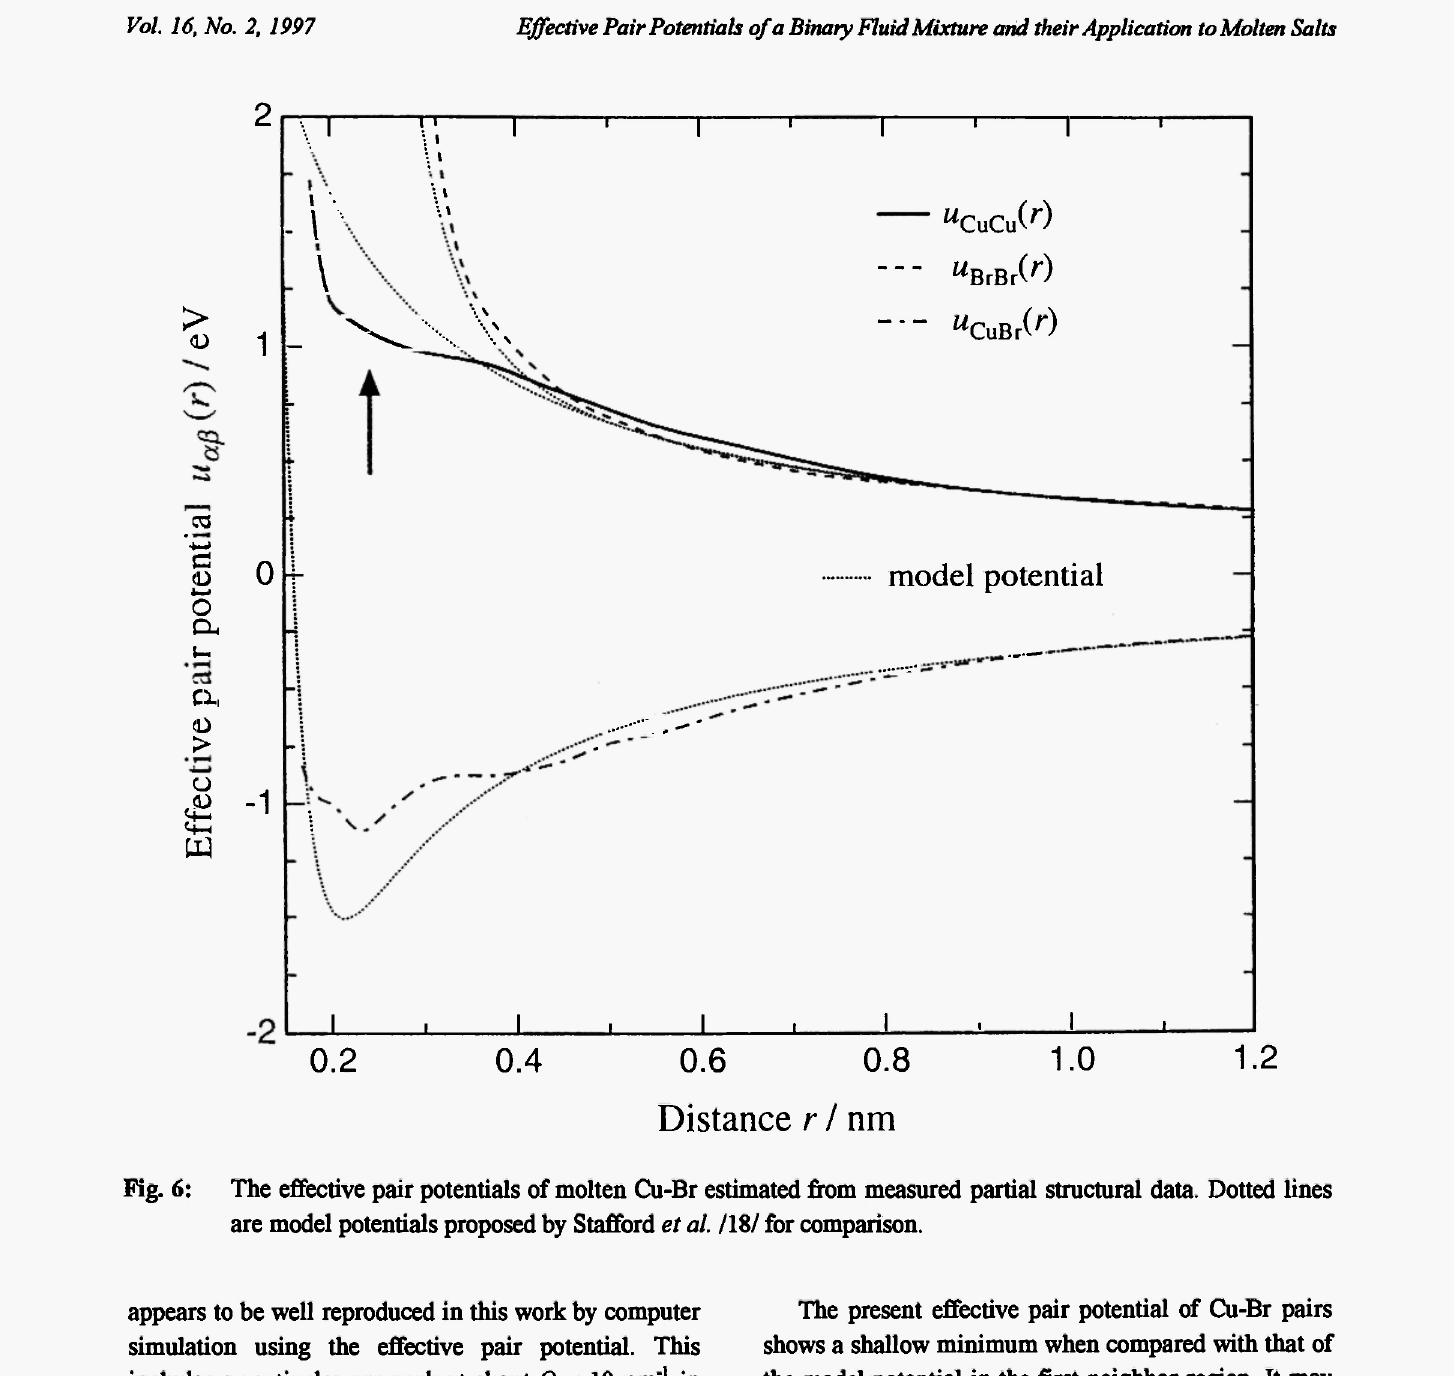
Fig. 6: The effective pair potentials of molten Cu-Br estimated from measured partial structural data. Dotted lines are model potentials proposed by Stafford et cd. /18/ for